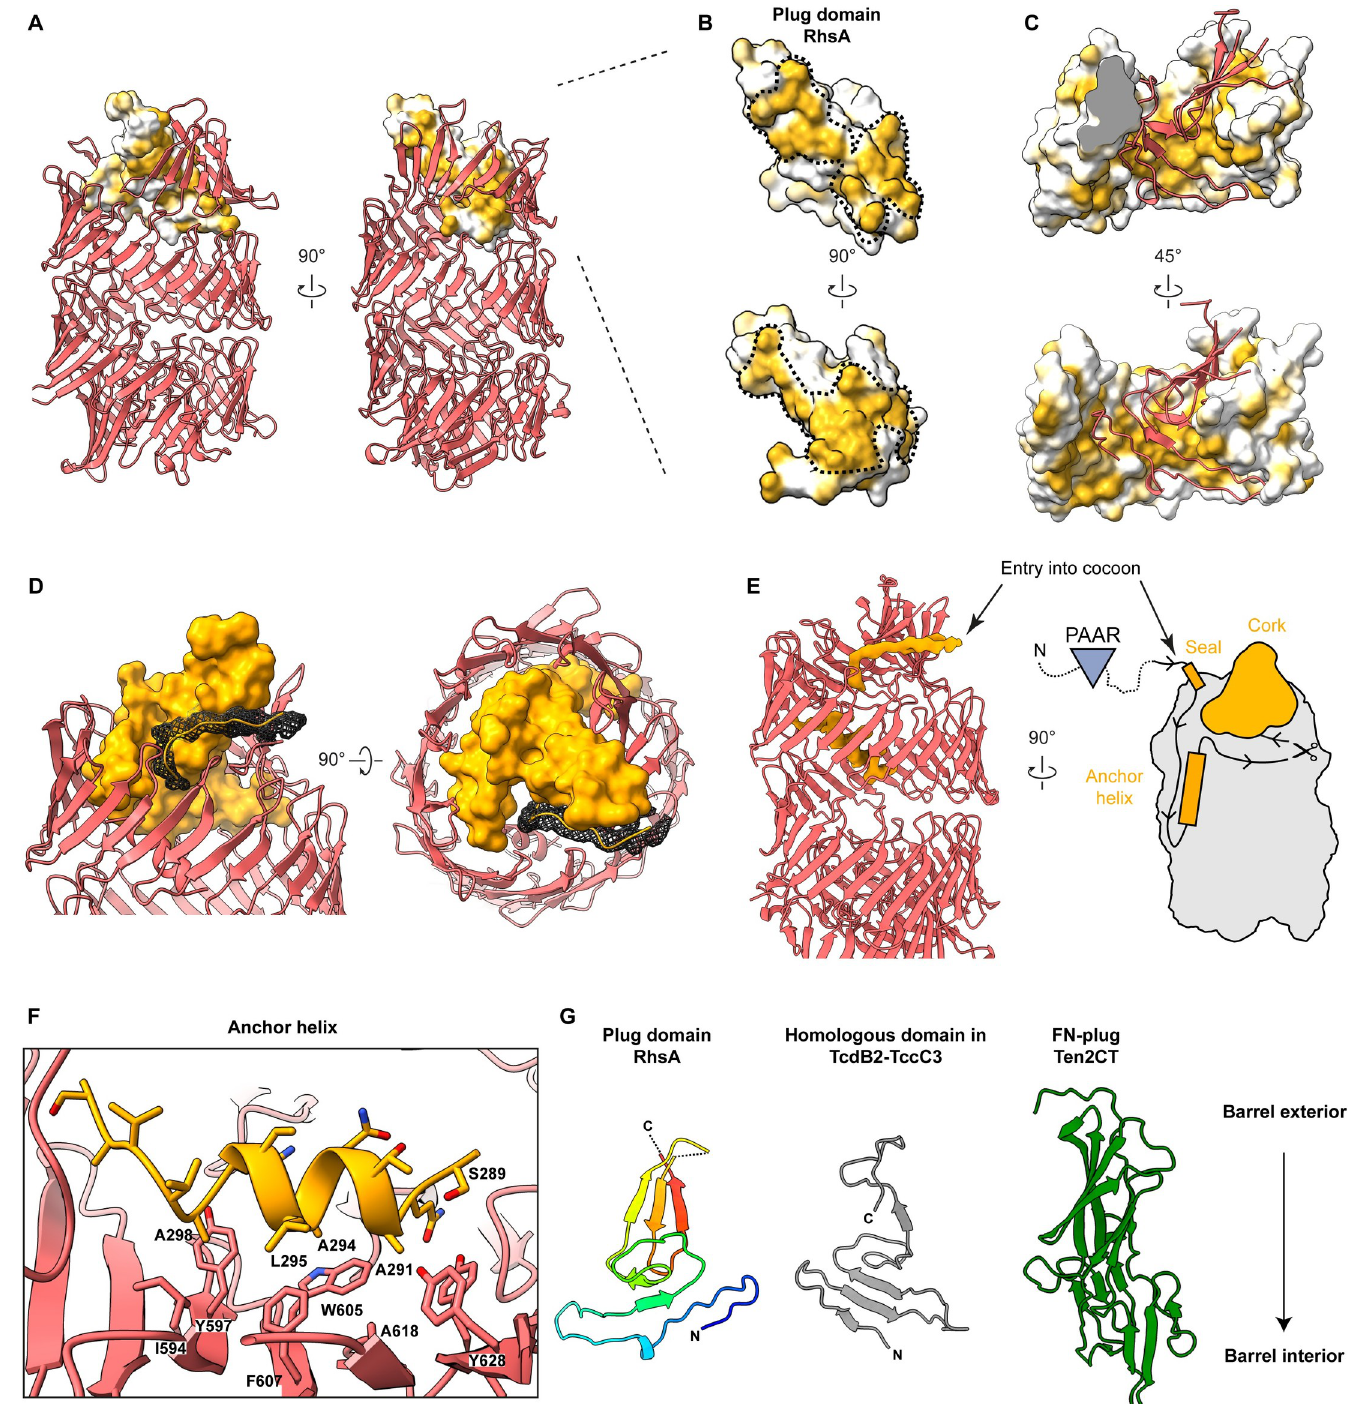
Fig 3. A unique plug domain seals the Rhs barrel of RhsA. (A) Surface representation of the cork domain of RhsA. The molecular surface is colored according to hydrophobicity where ochre and white indicate hydrophobic and hydrophilic regions, respectively. The Rhs barrel is shown as a cartoon. (B) Enlarged view of the cork domain of RhsA. The hydrophobic surface spirals around the domain as indicated by the black dashed line. (C) The upper Rhs repeats of RhsA possess complementary hydrophobic patches to those found on its plug domain (shown in cartoon representation, red). (D) The cocoon structure of RhsA is closed off by an N-terminal plug comprised of a ‘cork’ domain (orange, density representation), a ‘seal’ peptide (mesh), and an anchor helix (E, F). The seal and the cork density together form a cap structure. (E) The seal peptide, which also functions as the linker to the unmodelled PAAR domain, not only complements the shape of the cork but is also the entry